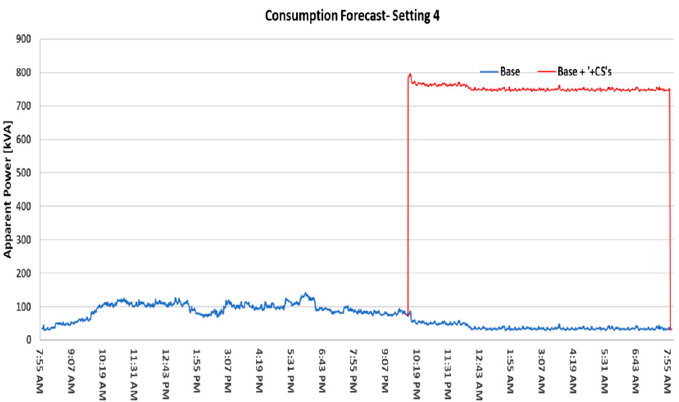
Figure 9. Consumption Forecast—Setting 4.